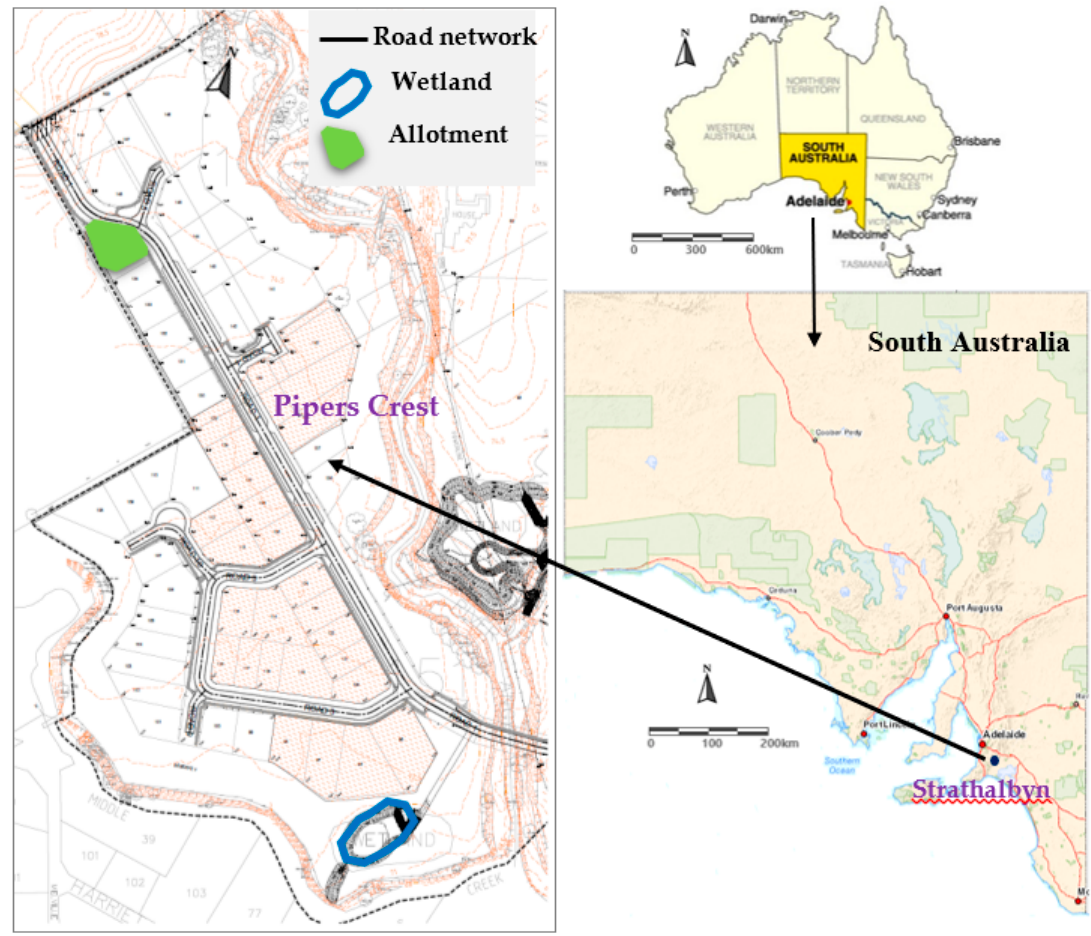
Figure 1. Pipers Crest development site, Strathalbyn, South Australia [43].